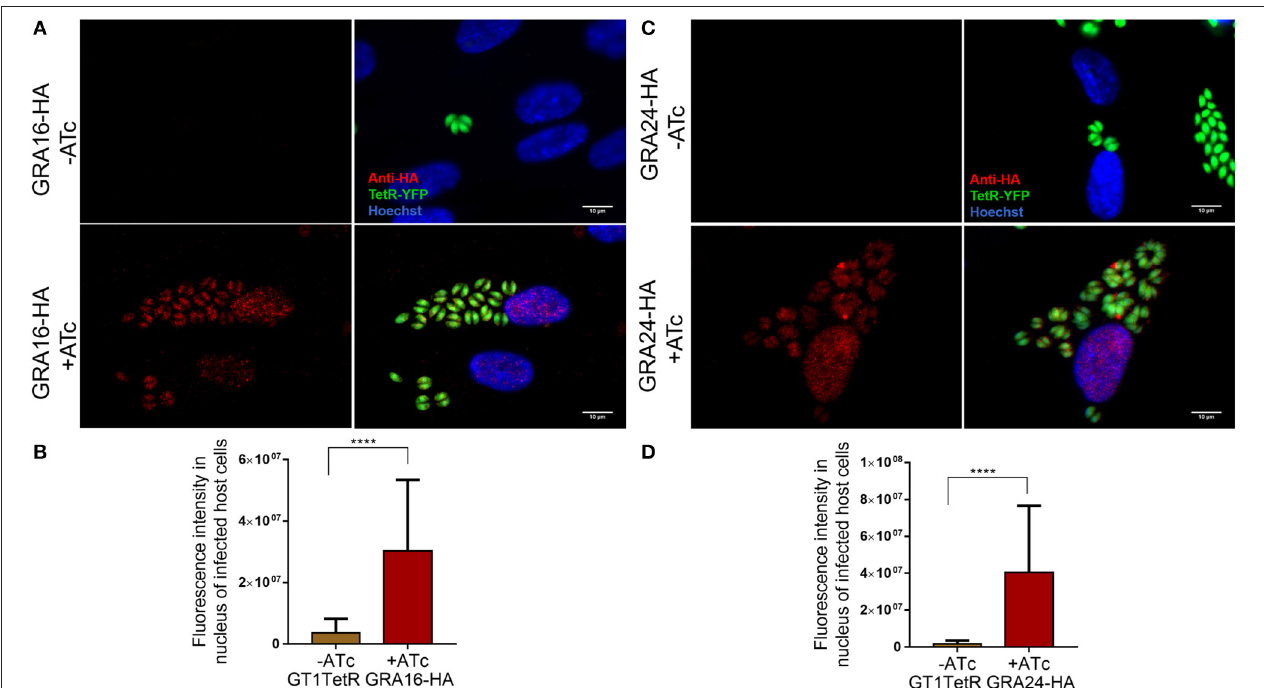
FIGURE 1 | GT1- TetR parasites express GRA16-HA and GRA24-HA only in the presence of ATc. A monolayer of HFFs were infected with single clones of GT1 Tet-R parasites, which contained either GRA16-HA or GRA24-HA cloned in front of a TetOn promoter, in the presence or absence of ATc. Cover slips were fixed 16h post infection and processed for IFA as described. Tet-R is YFP tagged and GT1 Tet-R parasites do not express any proteins that are HA-epitope tagged (first panel). In the absence of ATc, Tet-R represses the expression of GRA16-HA ( A first panel) and GRA24-HA ( C first panel). Repression by Tet-R is relieved only in the presence of 2 µ M ATc (second panel) allowing for the proper localization of GRA16-HA (A) and GRA24-HA (B) to the parasite PVM and host cell nucleus. Images are scaled to 10 µ m. Quantification of GRA16-HA (C) and GRA24-HA (D) secreted into the host cell nucleus only in presence of ATc was done using ImageJ. Error bars indicate mean with SD and significance was determined by performing Student’s t -test from 3 biological replicates using Graph Pad Prism7.0 (**** P <